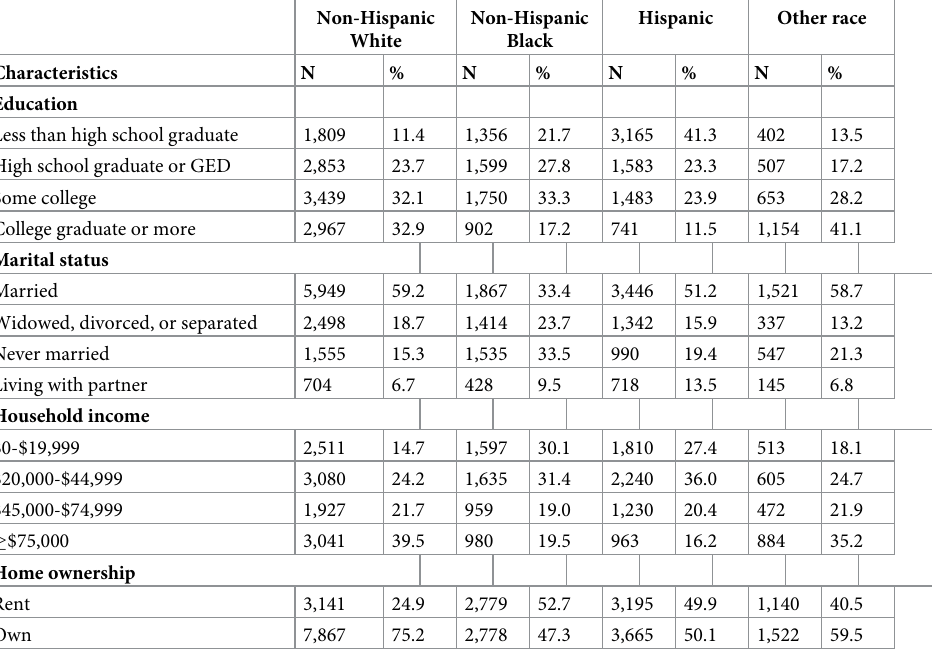
Table 2. Distribution of assets in study sample of U.S. adults by race/ethnicity (N = 26,382).